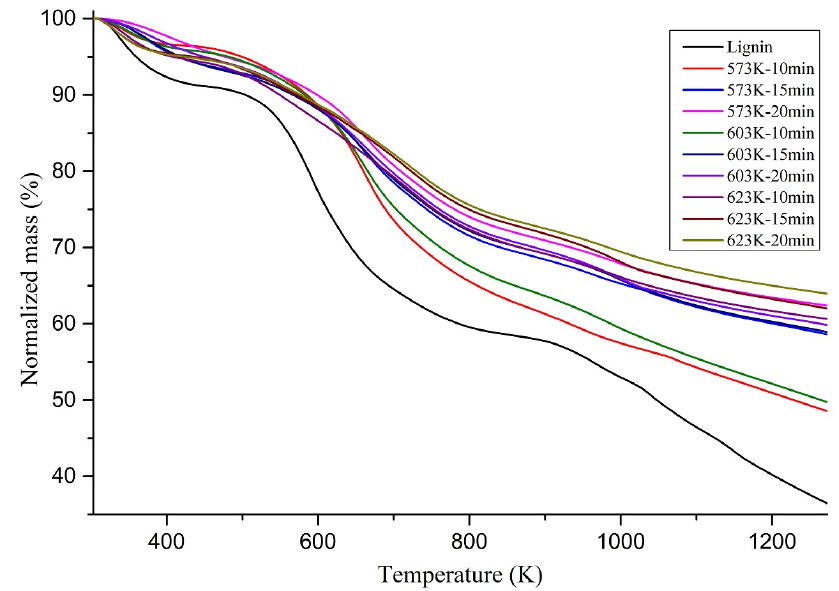
Figure 5. TG curves of lignin and the chars at 20 C/min heating rate under N 2 .